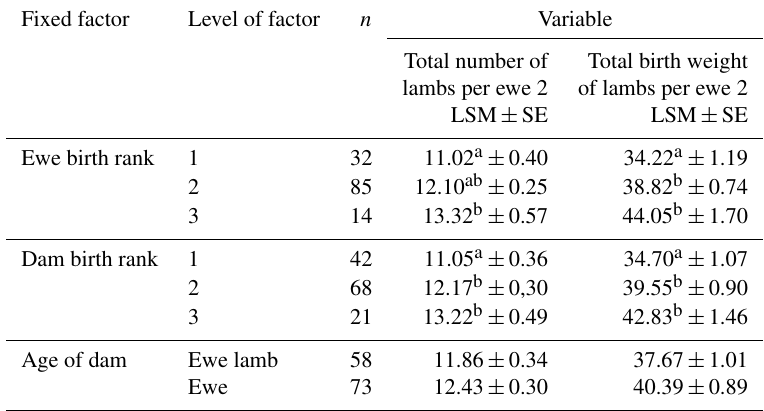
Table 3. Analysis of variance results of the total number of lambs per ewe 2 and total birth weight of lambs per ewe 2. Fixed factor Level of